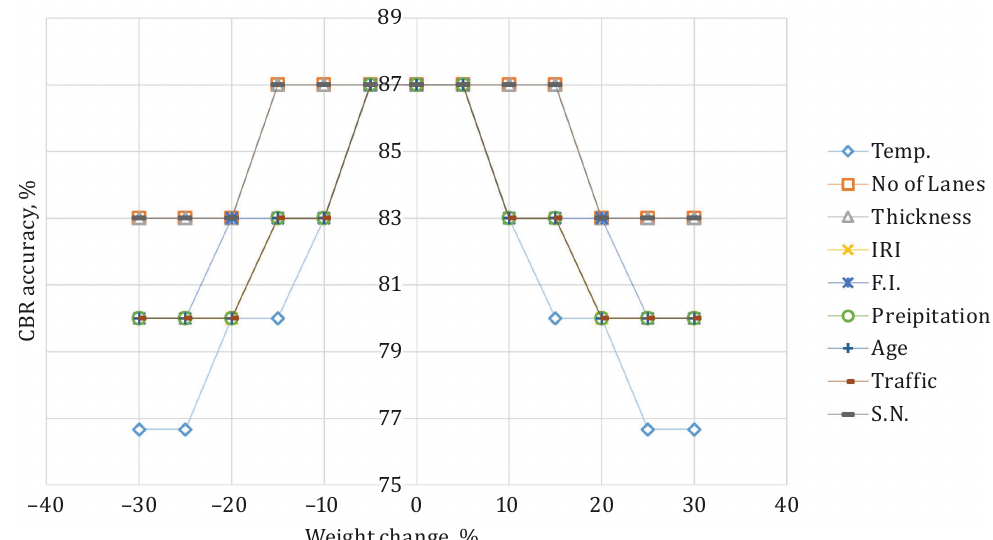
Figure 3. Results of sensitivity